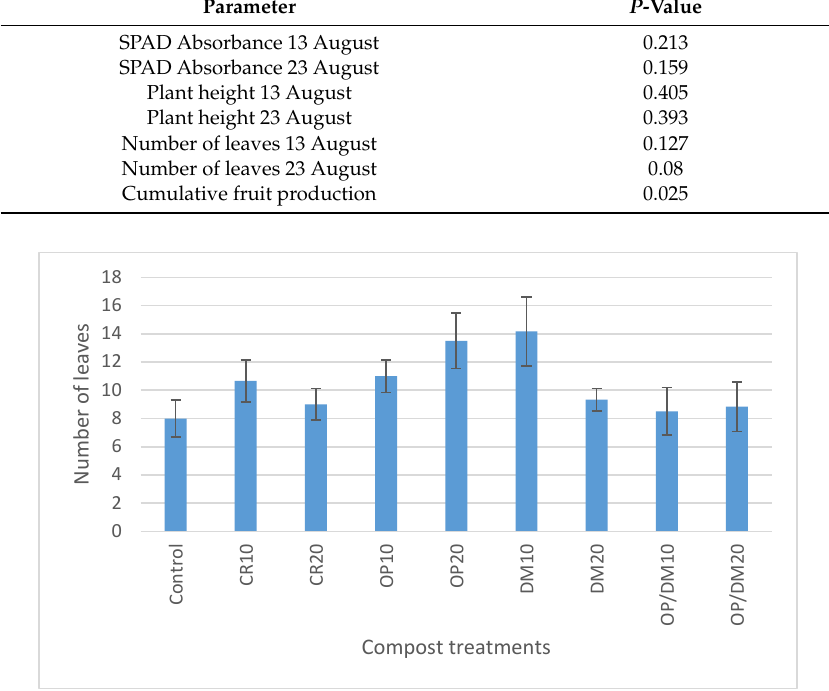
Figure 10. SPAD absorbance on 23 August 2018 as affected by different compost sources and rates. Error bars represent ± standard error ( P = 0.159, n = 6). Figure 11. Fresh weight production of bell pepper fruits per plant as affected by different compost sources and rates. Error bars represent ± standard error ( P = 0.025, n = 6).